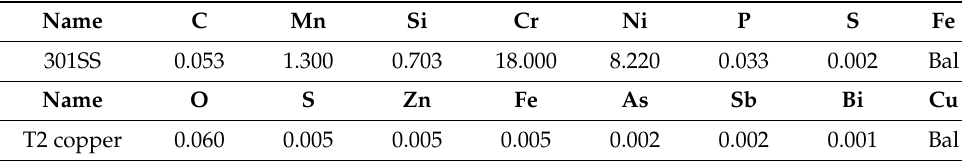
Table 1. Chemical compositions of the base metals (wt.%).